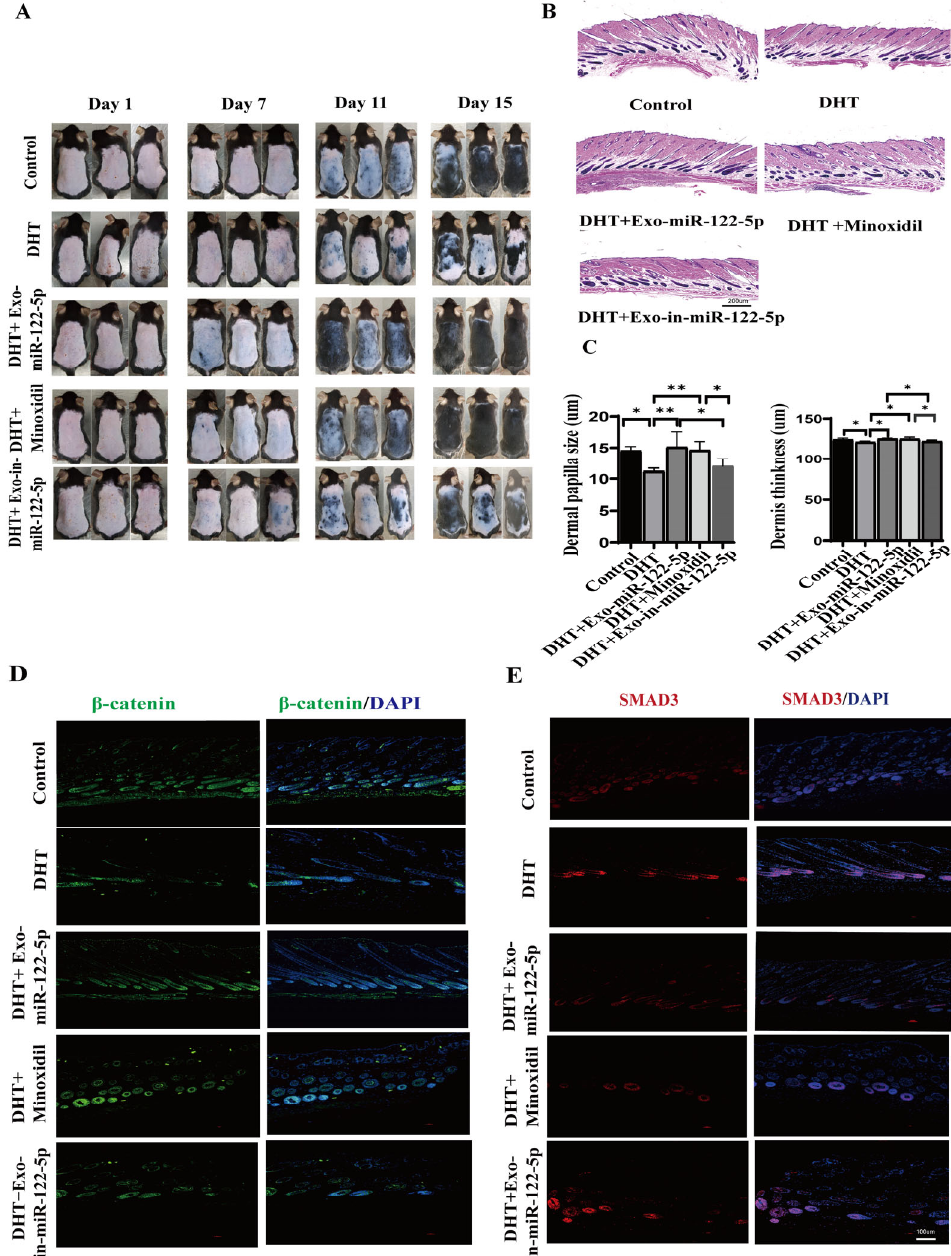
Figure 6. Exo ‐ miR ‐ 122 ‐ 5p mitigates the inhibitory effect of DHT on HFs in C57BL/6 mice. ( A ) All C57BL/6 mice were subcutaneously injected with 200 μ L of solution containing DHT (10 − 5 mol/L) or/and Exosomes (50 μ g/mL) after shaving, and the dorsal hair growth was observed and photo ‐ graphed every two days. The dorsal skin of C57BL/6 mice began to turn grayish ‐ brown on day 7. The dorsal hair coverage of minoxidil and Exos ‐ miR ‐ 122 ‐ 5p treated mice were significantly more than those in the DHT group on day 15, and the DHT + Exo ‐ in ‐ miR ‐ 122 ‐ 5p group showed lower hair coverage compared with the control group. ( B ) Hematoxylin and eosin (H&E) staining of C57BL/6 mouse dorsal skin treated with NS, DHT, DHT+Exo ‐ miR ‐ 122 ‐ 5p and DHT+Exo ‐ in ‐ miR ‐ 122 ‐ 5p. (Bar = 200 um.) ( C ) Hair bulbs and dermal thickness of C57BL/6 mouse dorsal skin in each group shown by H&E staining. ( D ) Immunofluorescence images of β‐ catenin and ( E ) the expression of SMAD3 on C57BL/6 mouse dorsal skin from different treatment groups. (Bar = 100 μ m) The data represent the means ± SD. * p < 0.05, ** p < 0.01.